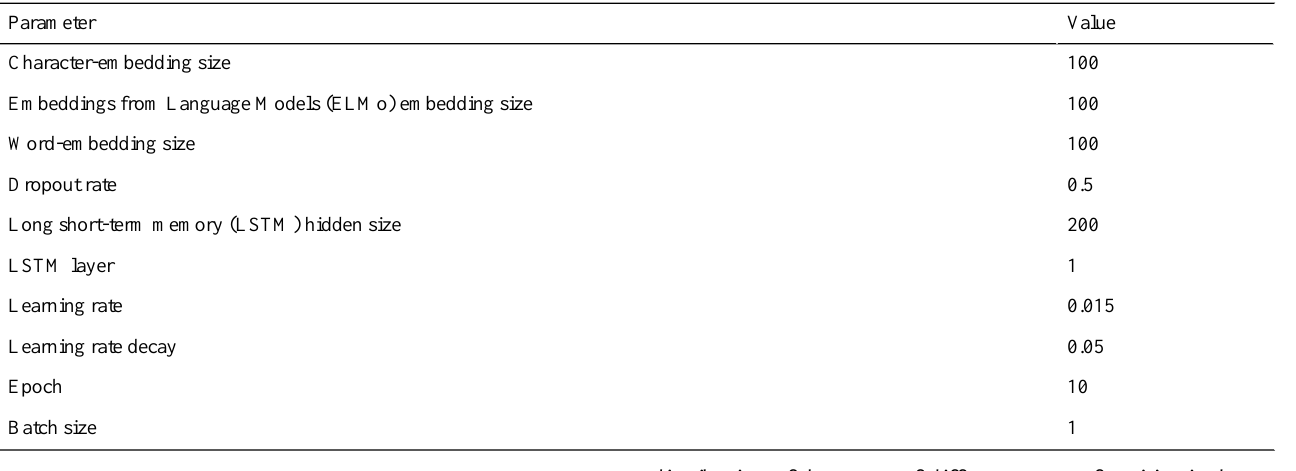
Table 1. Hyperparameter settings of the proposed approach.